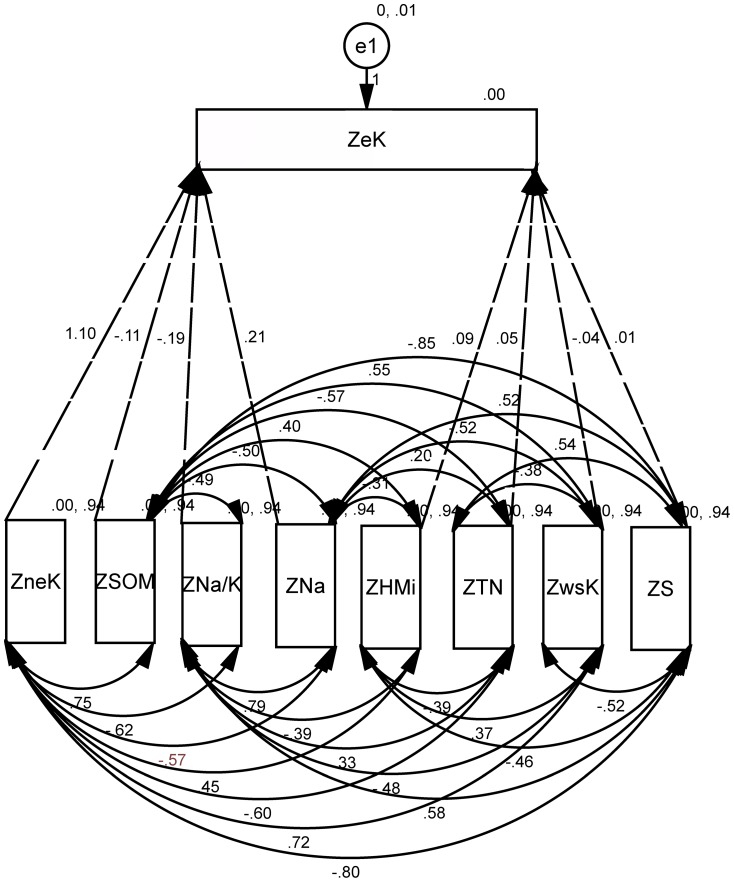
Path model of exchangeable potassium (eK, solid line for double arrow, dashed-line for single arrow, and single arrow flows into ZwsK).